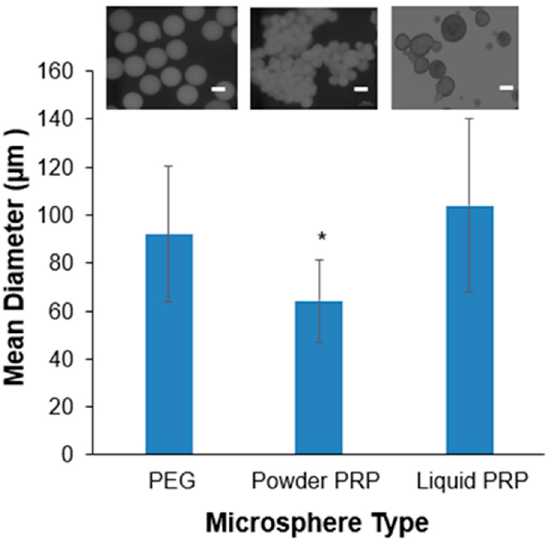
Figure 3. Mean diameters of PEG-only, powder PRP, and liquid PRP-loaded microspheres at olive oil flow rate of 1000 µL/min and PEG precursor solution flow rate of 10 µL/min. Microspheres were prepared with 4-arm PEG–Ac and PEG–diSH as a crosslinker at 10% w/v in PEG. Powder and liquid